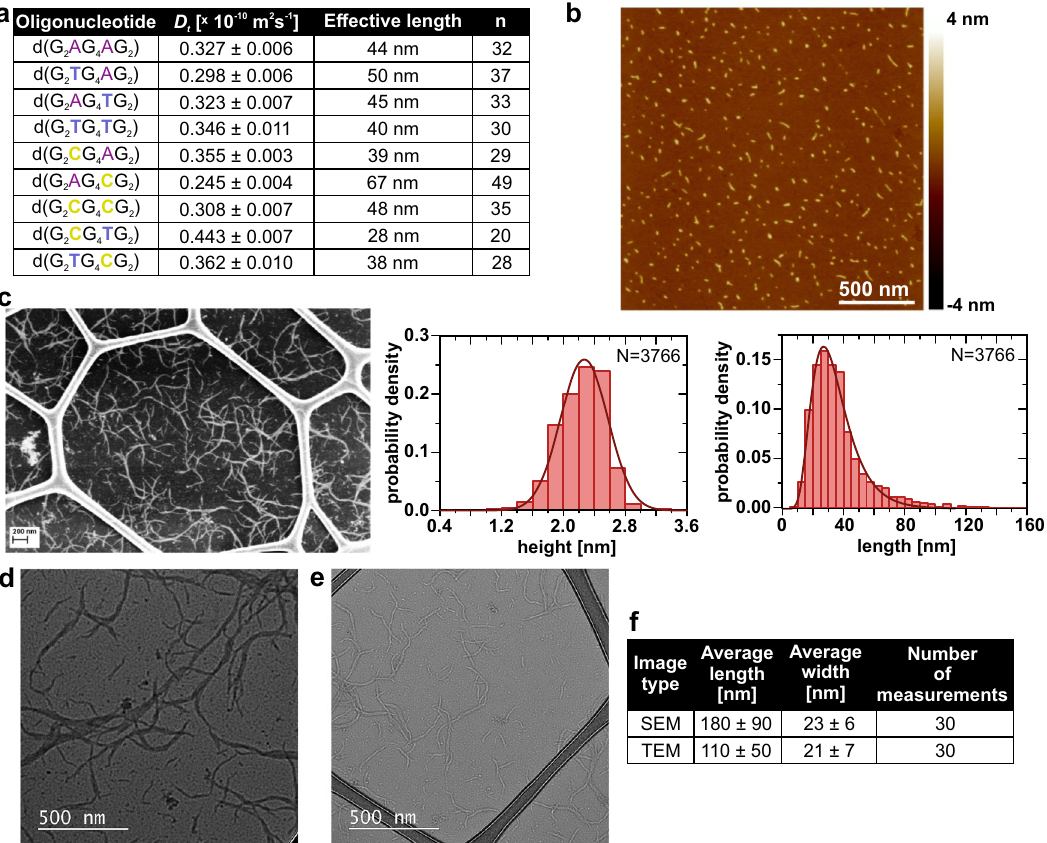
Fig. 4 A single loop residue substitution considerably extends G-wires length. a Table shows D t , effective lengths and number of stacked Qt-type building blocks ( n ) for Qnt-type G-wires obtained from DLS. b Representative AFM height image of G-wires formed by d(G 2 AG 4 CG 2 ) with corresponding length and height histograms. Low deposition concentration allows visualization of individual d(G 2 AG 4 CG 2 ) G-wires with 2.3 ± 0.1 nm mean height and mean length 31.6 ± 0.3 nm. Statistics collected over 12 images. c SEM image of G-wires shows their random distribution on GO support. We see